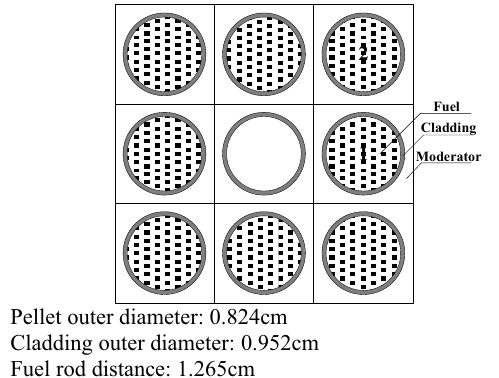
Figure. 4 Geometric Configuration And Parameter of Multicell